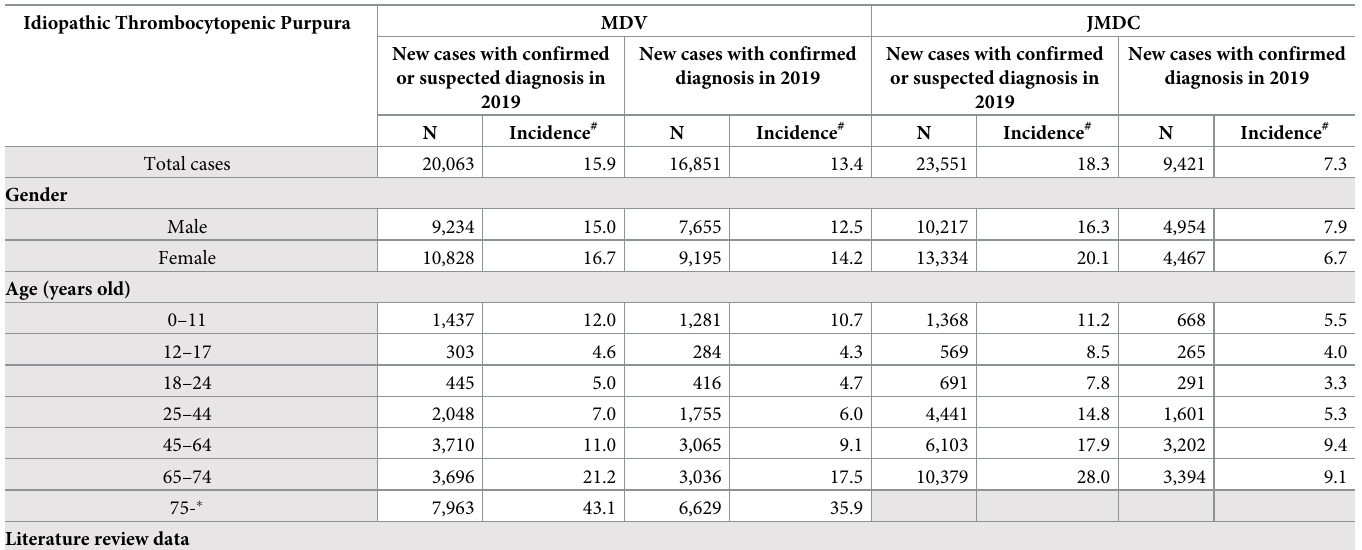
Table 6. Estimated incidence of idiopathic thrombocytopenic purpura.